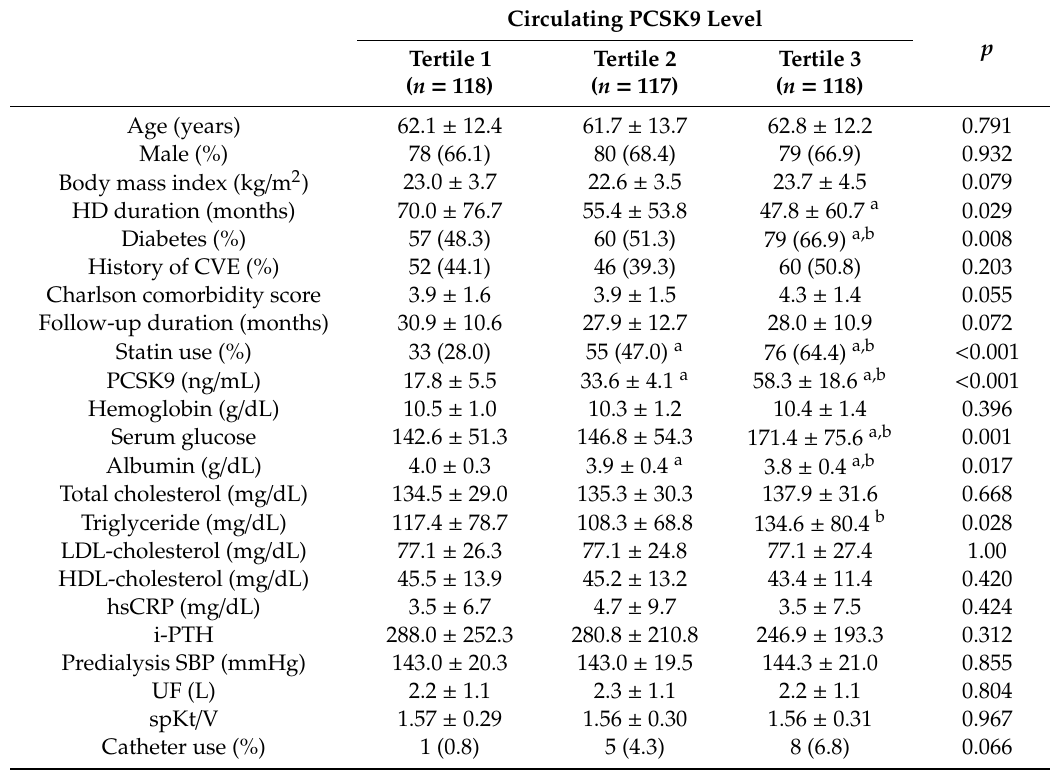
Table 1. Baseline demographic and laboratory data of study